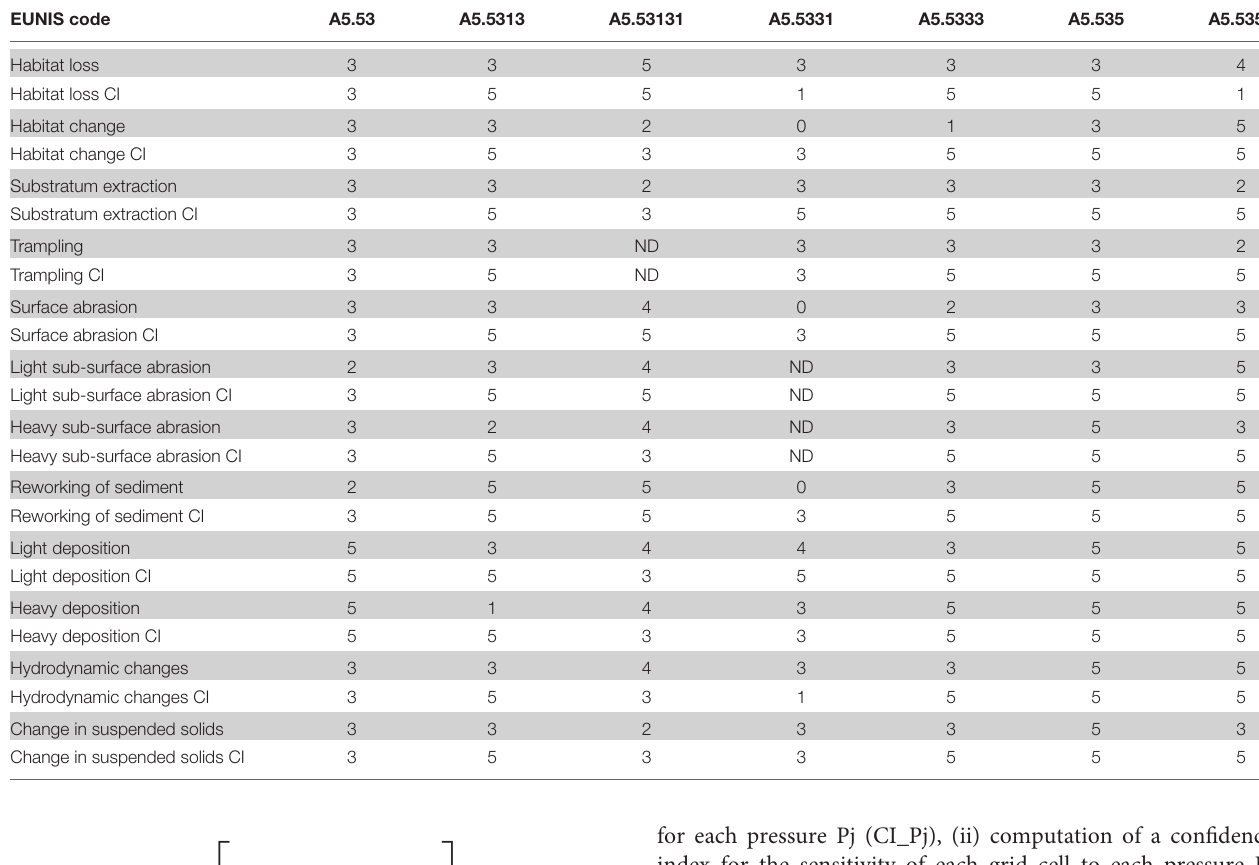
TABLE 2 | Extract of the sensitivity matrix for physical pressures and EUNIS habitats type A5.53 [gray lines: sensitivity evaluation between benthic habitats and physical pressures, white lines: confidence index (CI) associated with the evaluation (value between 0 and 5), ‘ND’: undefined, A5.53: Sublittoral seagrass beds, A5.5313: Mediterranean Cymodocea beds, A5.53131: Association with Cymodocea nodosa on well sorted fine sands, A5.5331: Zostera marina/angustifolia beds on lower shore or infralittoral clean or muddy sand, A5.5333: Association with Zostera marina in euryhaline and eurythermal environments, A5.535: Posidonia beds, A5.5353: Facies of dead “mattes” of Posidonia oceanica without much